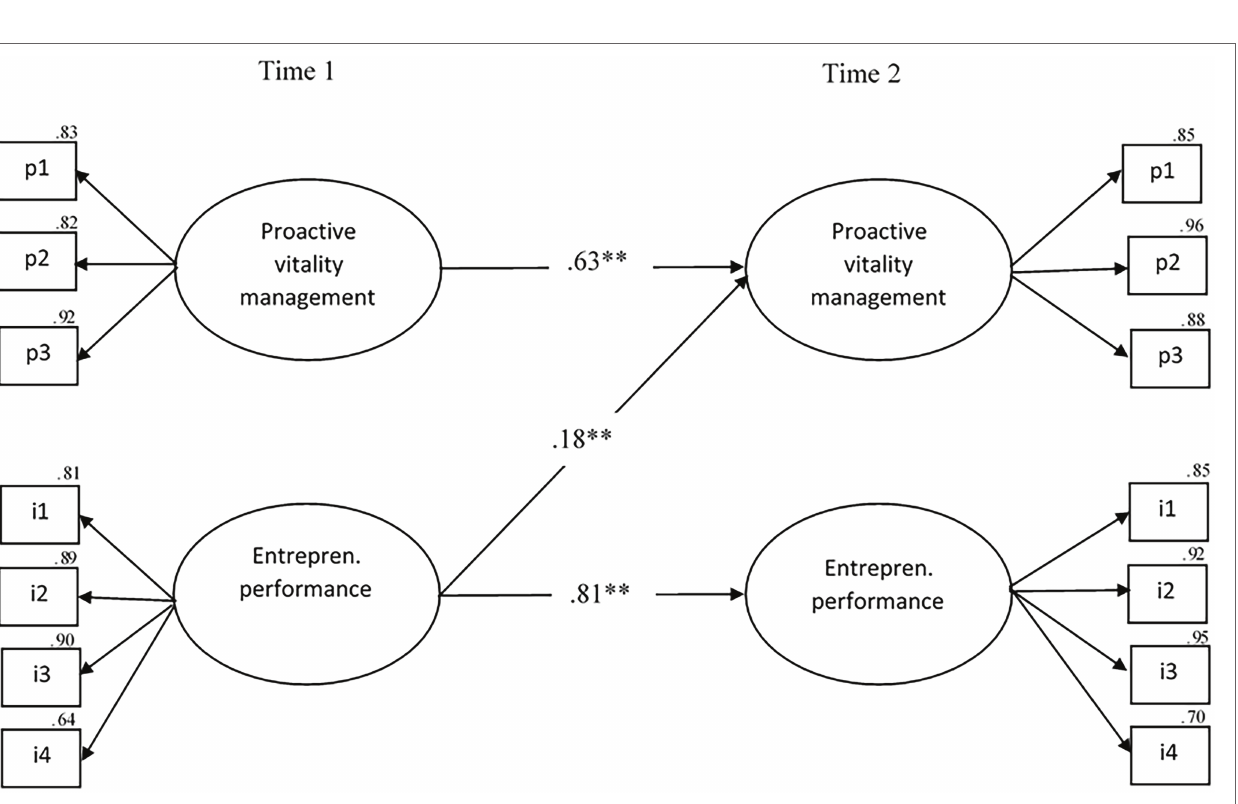
FIGURE 2 | The final model of the statistically significant cross-lagged relationships between proactive vitality management and entrepreneurial performance. N = 249, * p < 0.01, ** p < 0.001, pl − p3 parcels 1 through 3, i1–i4 = items 1 through 4. entrepren =